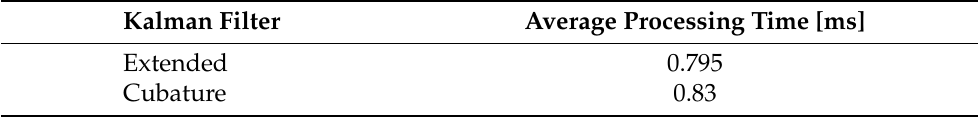
Table 7. EKF and CKF processing time